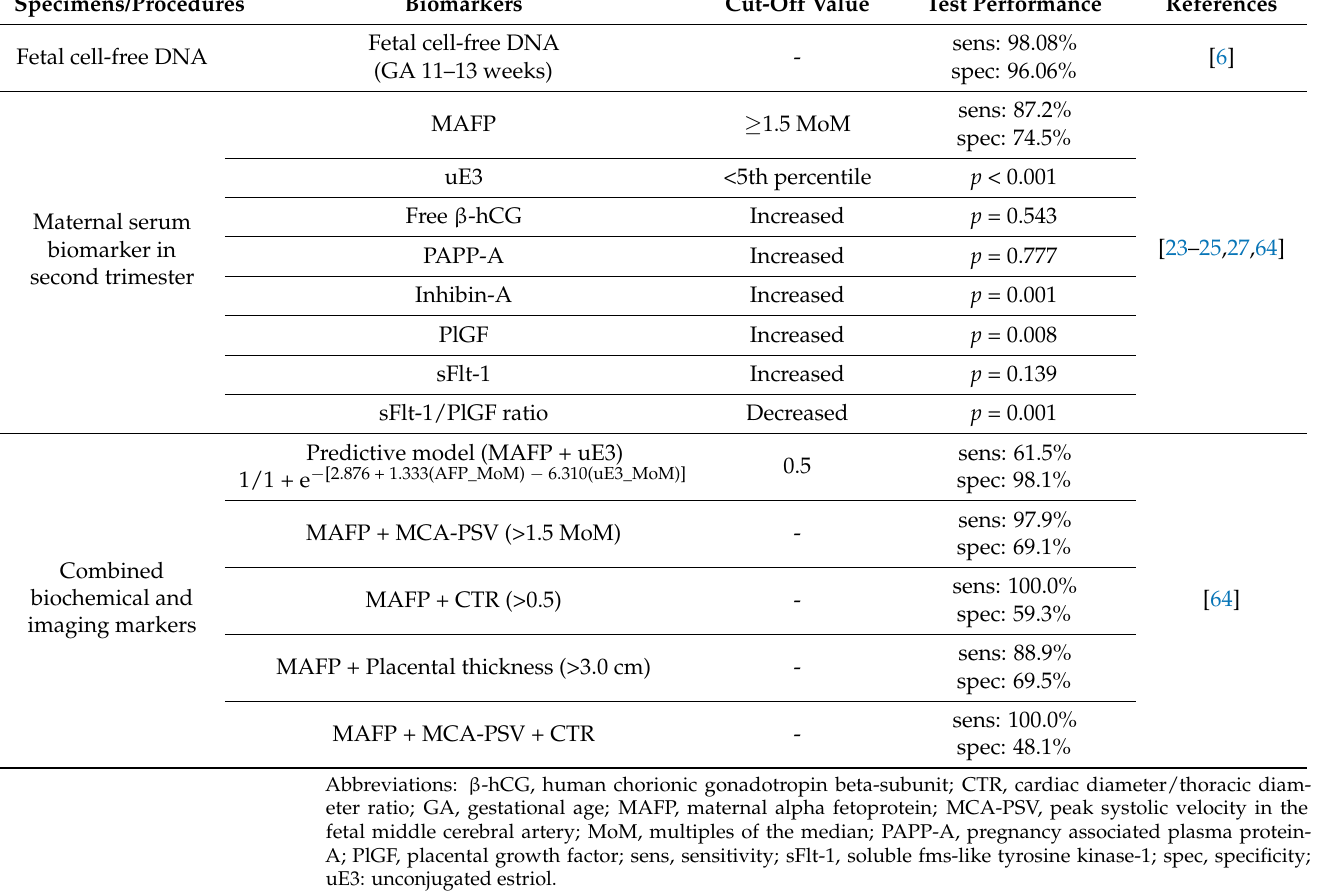
Table 2. Performance of Maternal Biomarkers in Predicting Fetal Hb Bart’s Disease.